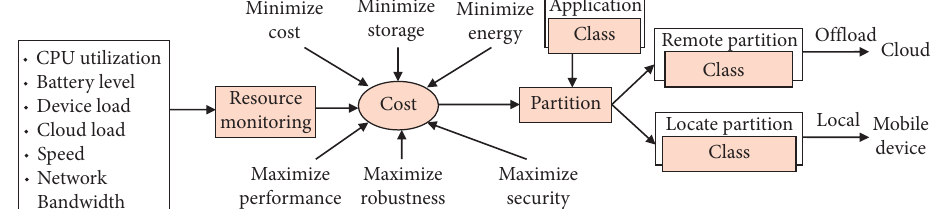
Figure 3: System module.